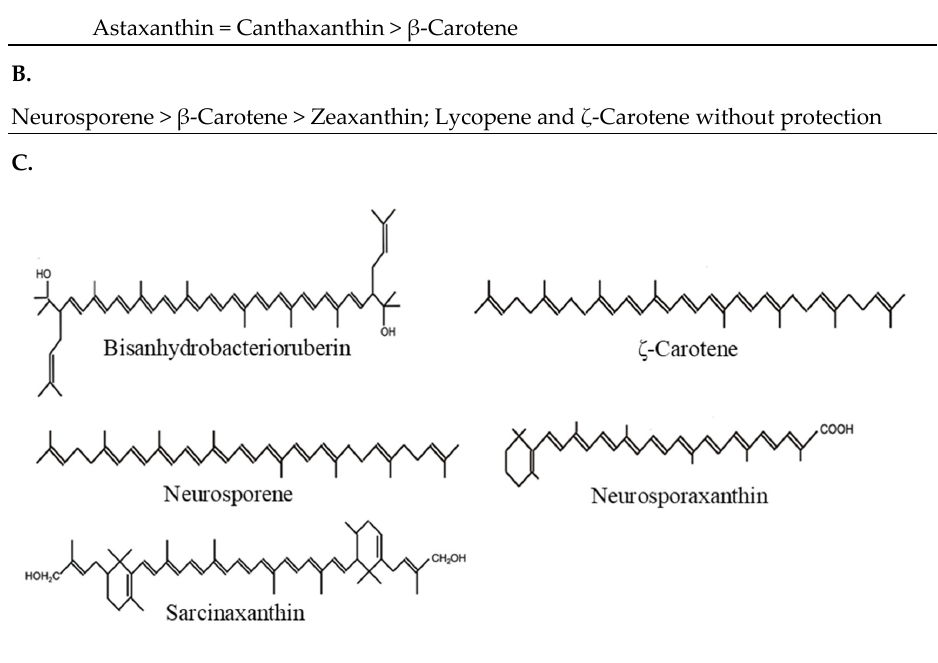
Figure 4. Protection by carotenoids against peroxyl radicals ( A ), against UV with α‐ terthienyl as